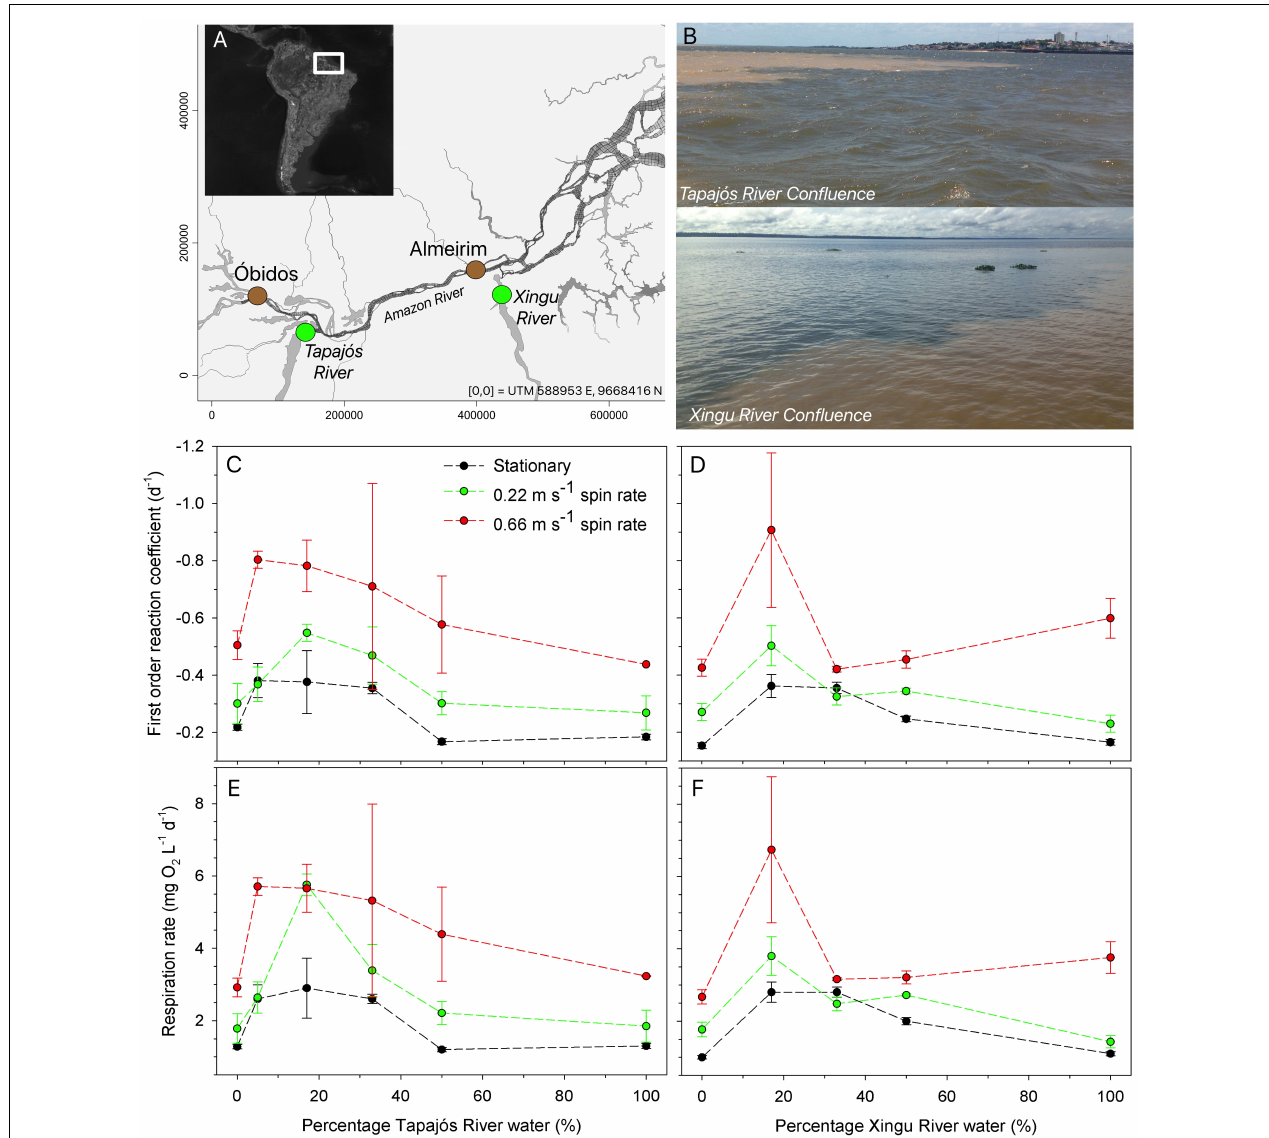
FIGURE 1 | (A) Incubation experiments were performed using water collected from the Amazon River mainstem at Óbidos and Almeirim and in two clearwater tributaries—the Tapajós and Xingu rivers. (B) Water collected in the Amazon River mainstem was also mixed with water from the Tapajós (top) and Xingu rivers (bottom) on the days pictured. Pseudo first order reaction coefficients ( k (cid:48) ) were measured for these different mixtures at three rotational velocities for the (C) Tapajós and (D) Xingu rivers and used to calculate respiration rates (E,F) . Error bars represent ± 1 standard deviation calculated by propagating uncertainty in our calculations and variability between replicates ( n = 2 for rotating chambers and n = 1 for stationary chamber).